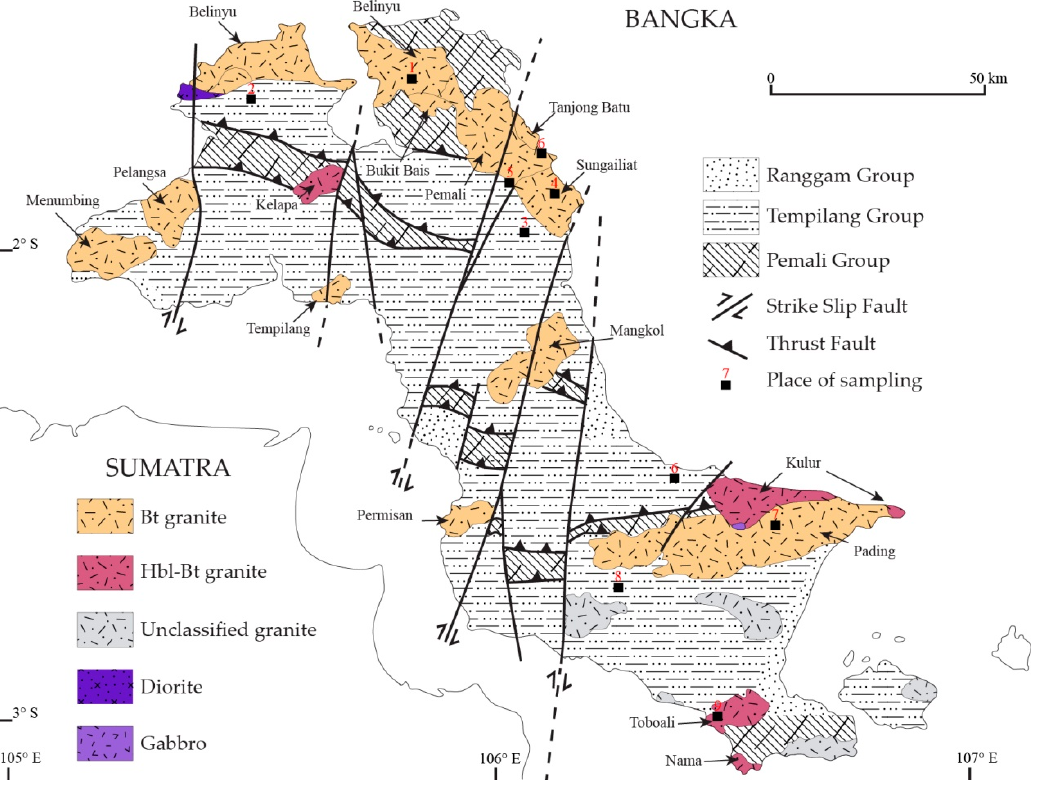
Figure 1. Geological map of Bangka Island (modified from